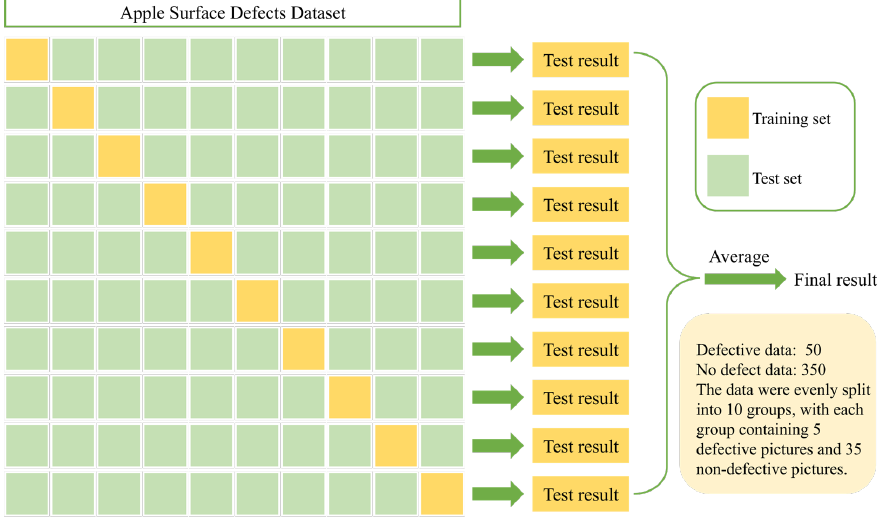
Table 10. The performance of the ASDINet trained between 45-40 defective images.